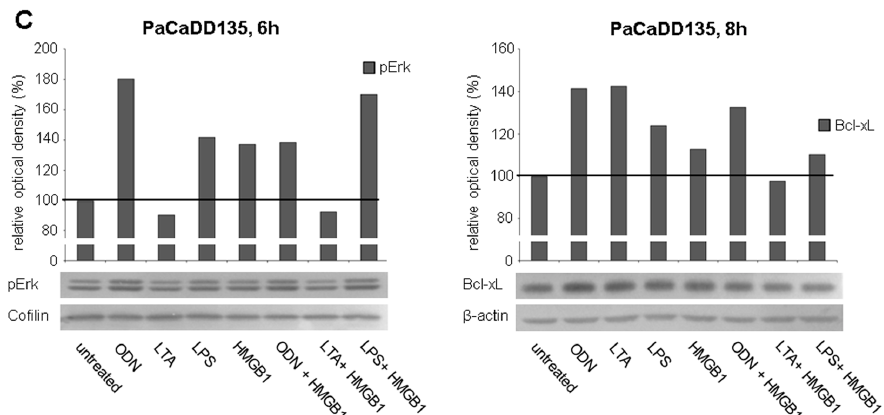
Figure 8. Western blot analysis of pErk and Bcl-xL in different human pancreatic cancer cells after treatment with TLR ligands: BxPC-3 ( A ); MIAPaCa-2 ( B ); and PaCaDD135 cells ( C ) were incubated with ODN, LTA, LPS, HMGB1, ODN + HMGB1, LTA + HMGB1, and LPS + HMGB1 and analyzed